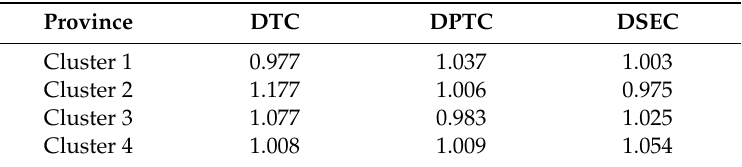
Table 4. Average decomposed indices of cluster analysis.